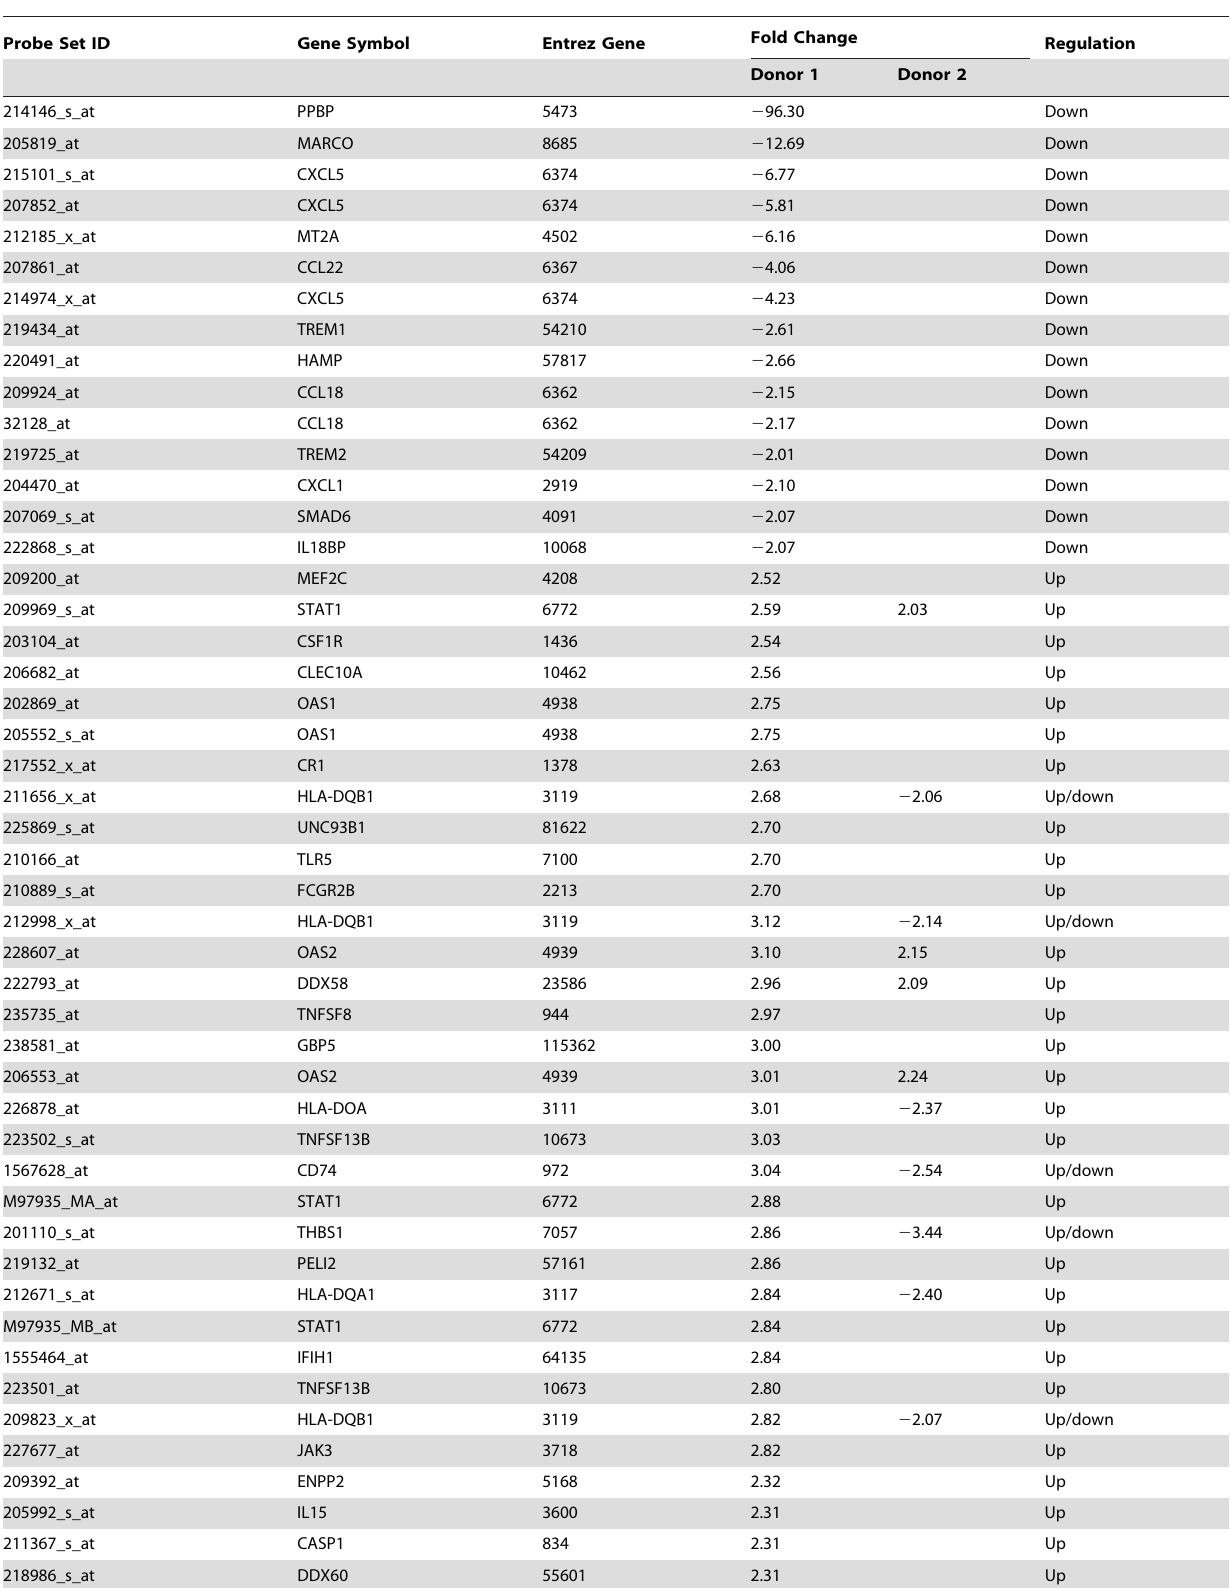
Table 1. Differentially expressed genes (fold change . 2.0) associated with immune response (GO: 0006955) upon Ad-Vpr infection in Donor 1 and Donor